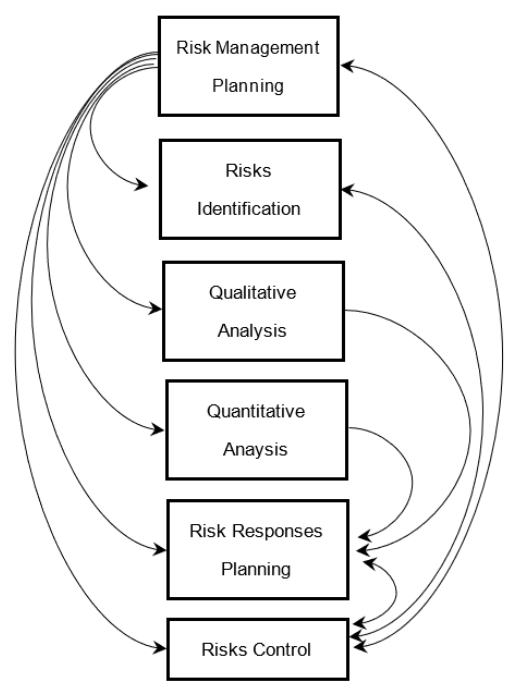
Figure 2. Main structures attributed to risk management [31].